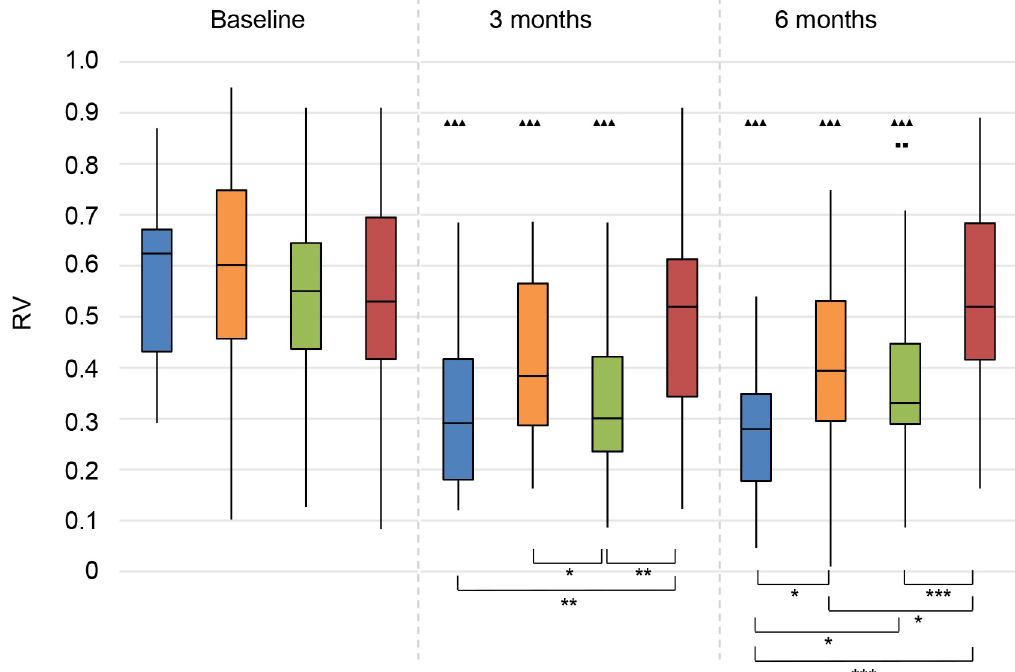
Fig 15. Abbreviated Profile for Hearing Aid Benefit questionnaire (APHAB). Reverberation (RV). Statistical difference compared to baseline. ▲▲▲ = p < 0.001; ▲▲ = p < 0.01; ▲ = p < 0.05. Statistical difference compared to 3 months follow- up. ■■■ = p < 0.001; ■■ = p < 0.01; ■ = p < 0.05. Statistical difference between groups at same follow-up moment. ��� = p < 0.001; �� = p < 0.01; � = p <